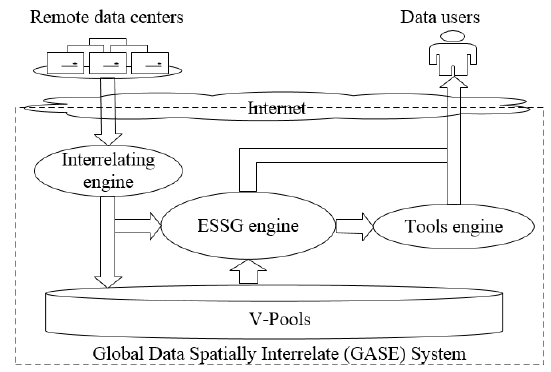
Fig.3 Architecture of GASE. GASE is mainly composed of V-Pools, ESSG engine, interrelating engine and tools